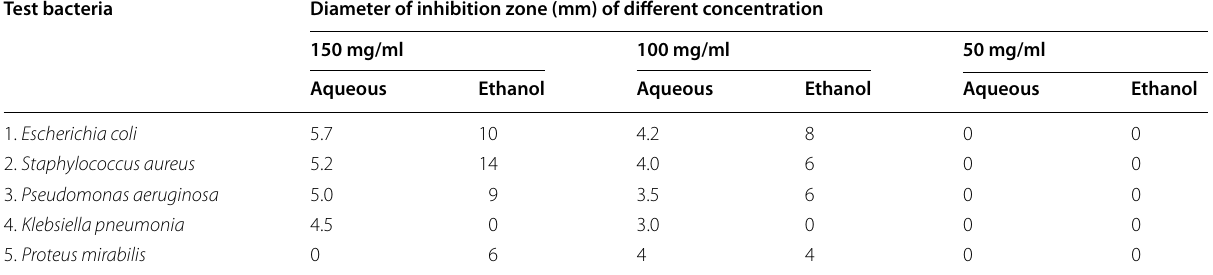
Table 3 Antibacterial activity of different concentrations of aqueous/ethanol A. cepa extracts Test bacteria